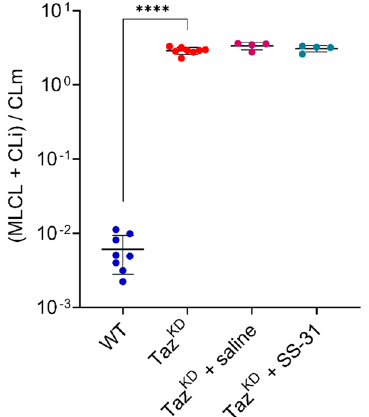
Figure 3. (MLCL + CLi)/CLm ratios calculated by MALDI-TOF/MS analysis of mitochondria. Mitochondrial lipids were analysed by (−) MALDI analysis (in triplicate for each sample) and ratios were calculated as described in “Methods”. The scatter plot shows the measurements of all mitochondrial samples for each group of mice (8 WT, 8 Taz KD , 4 Taz KD + saline, and 4 Taz KD + SS-31) and the average values with the error bars indicating SD (****p < 0.0001). The y -axis shows a logarithmic